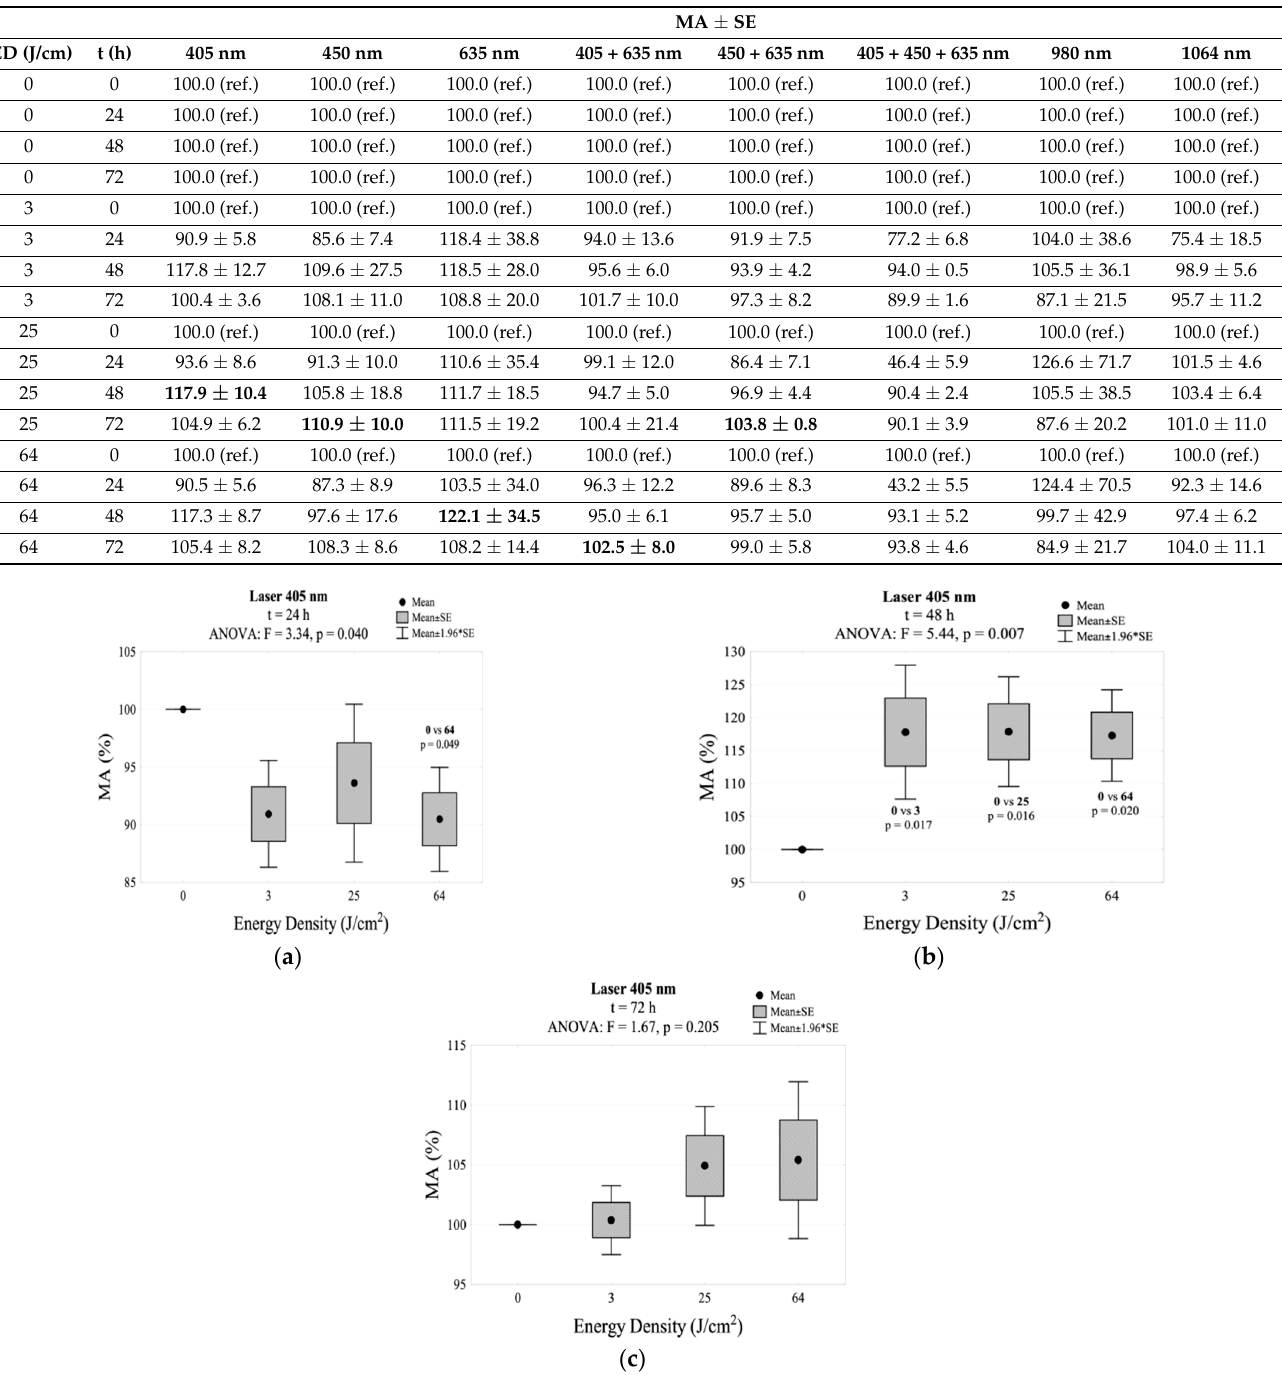
Figure 1. MA values measured ( a ) 24 h, ( b ) 48 h, and ( c ) 72 h after irradiation using the 405 nm laser.